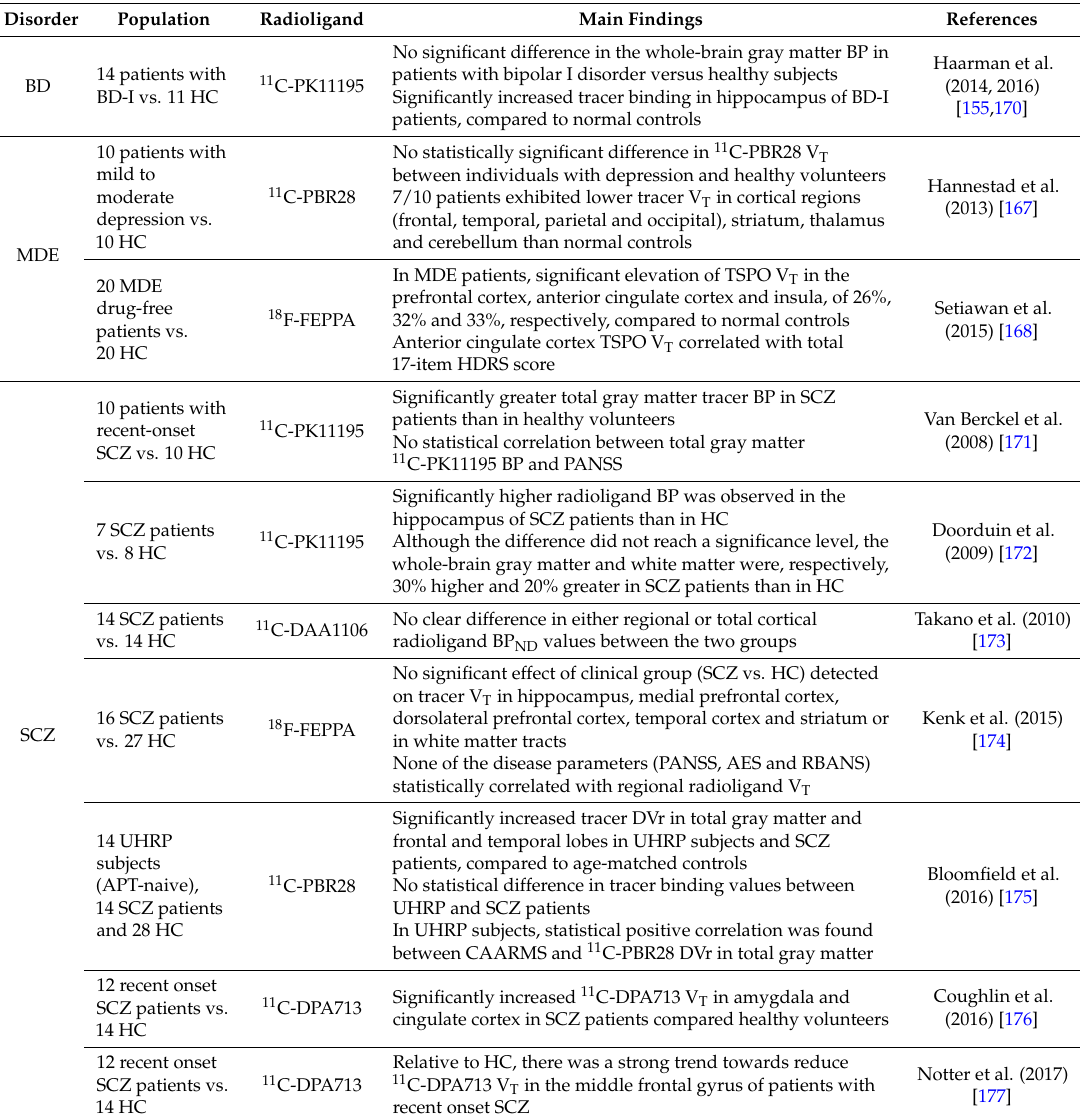
Table 6. PET imaging studies assessing TSPO tracers in psychiatric